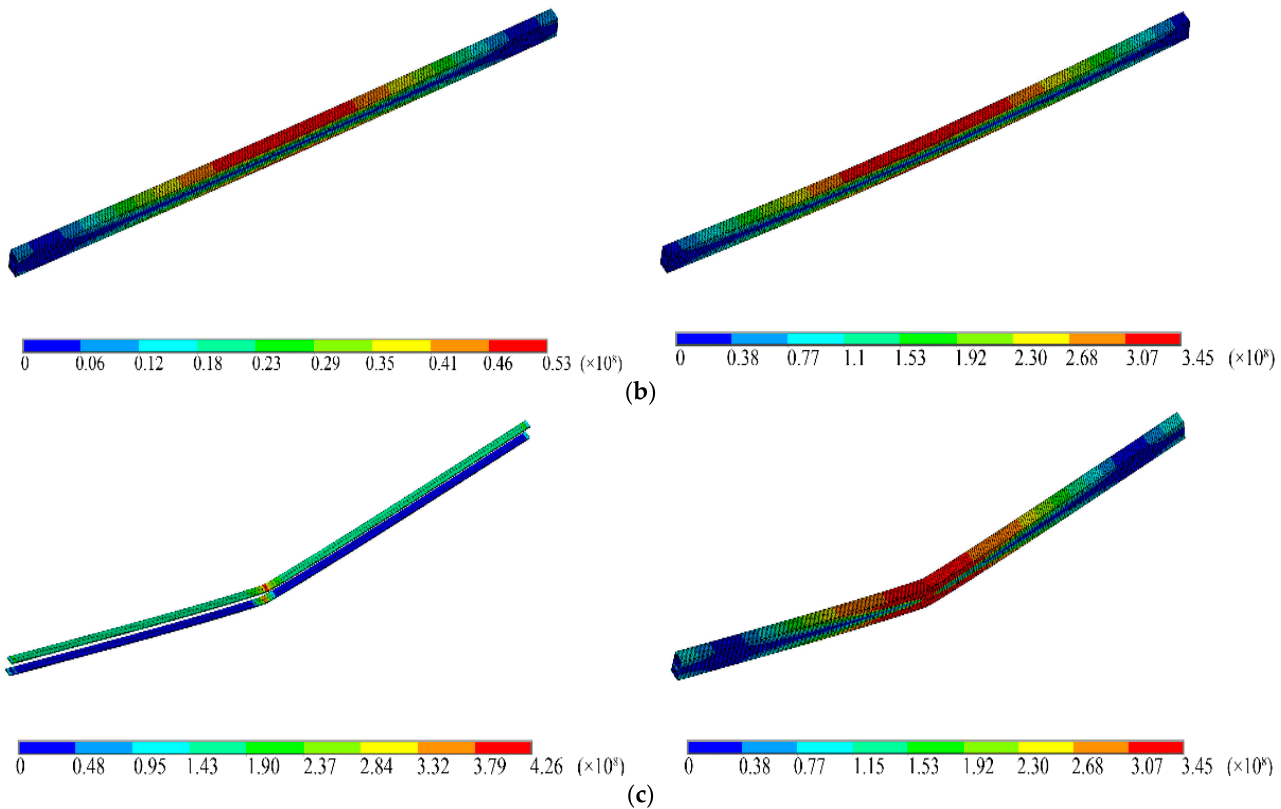
Figure 8. Stress distribution and deformation of example CSA-20-1.91 at points A, B, and C in Figure 6a. ( a ) von Mises stresses and lateral deformations for the initial yield state of the core of the CSA-BRB at point A in Figure 6a. ( b ) von Mises stresses and lateral deformations for the ultimate state of the core of the CSA-BRB at point B in Figure 6a. ( c ) von Mises stresses and lateral deformations for the final state of the core of the CSA-BRB at point C in Figure 6a.